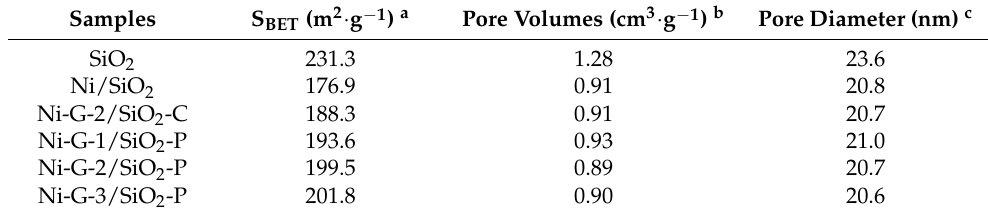
Table 1. Textural properties of support and catalysts.